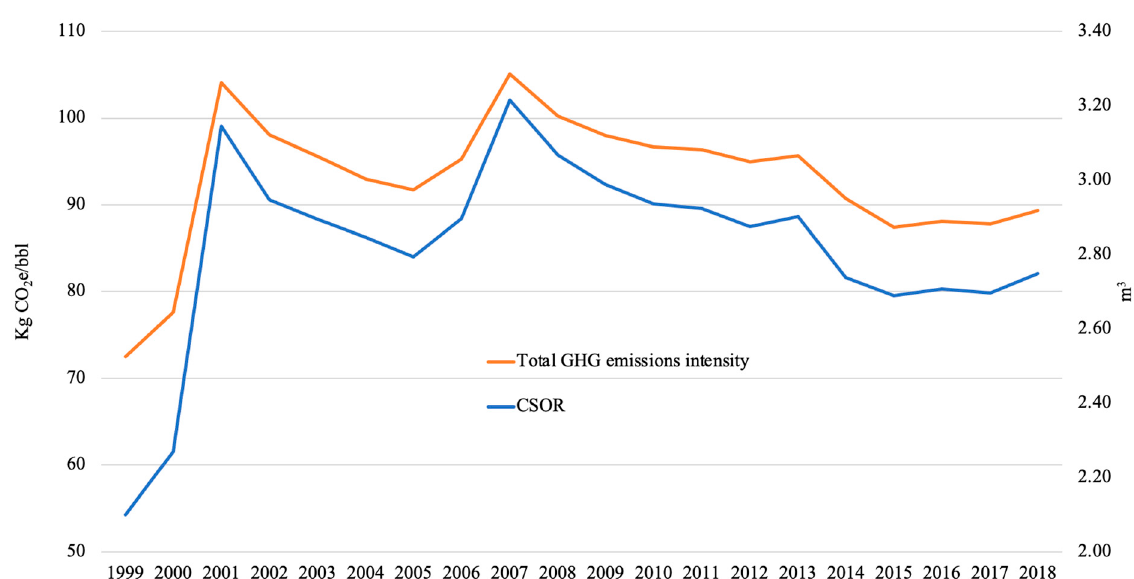
Figure 5. GHG emissions intensity and cSOR per year for SAGD operations from 1999–2018 (from Case